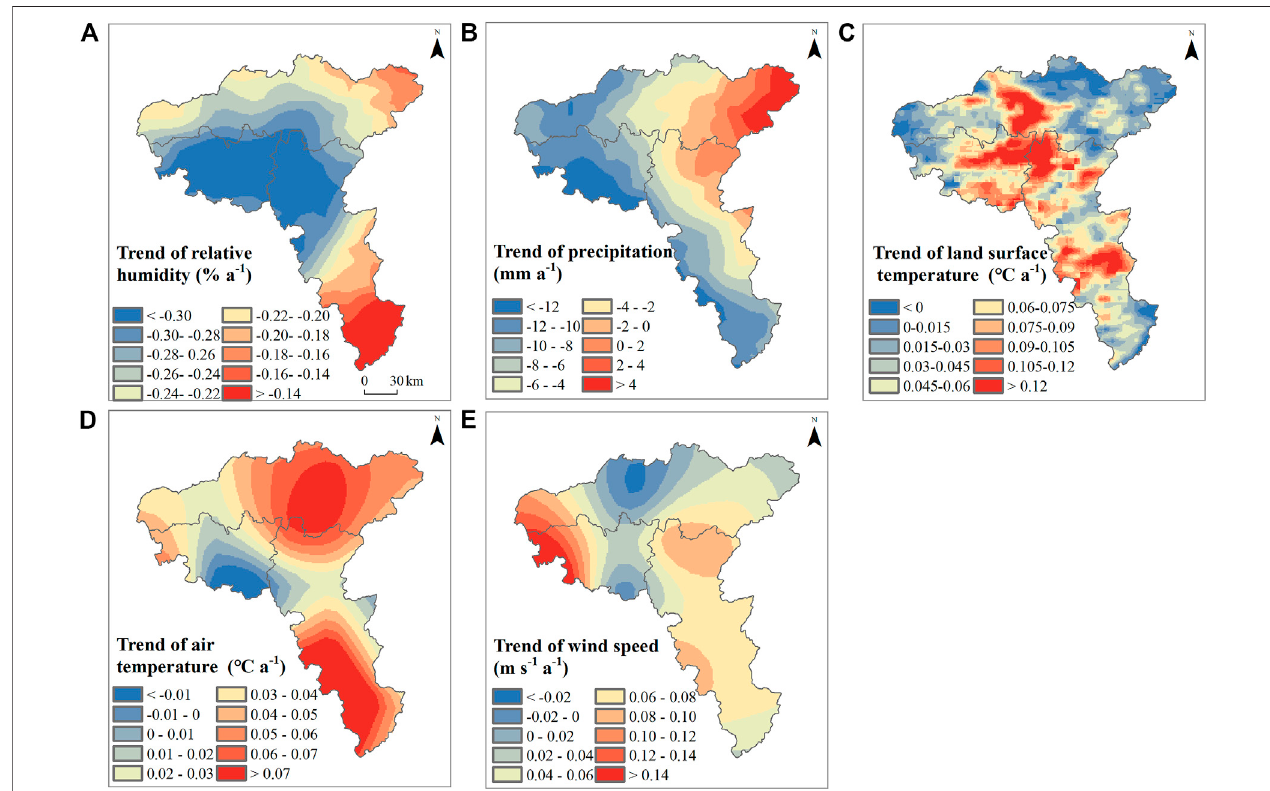
FIGURE3| Spatialpatternsofthetrendsin (A) relative humidity, (B) precipitation, (C) landsurfacetemperature, (D) airtemperatureand (E) windspeedfrom2001 to 2014.